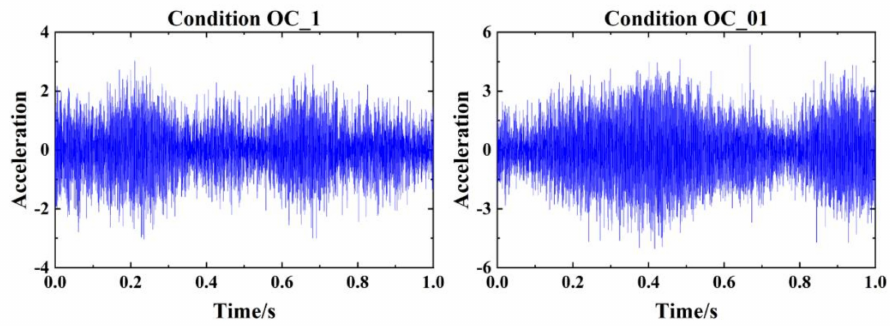
Figure 12. Time domain waveform diagram of bearing load after wavelet noise reduction.